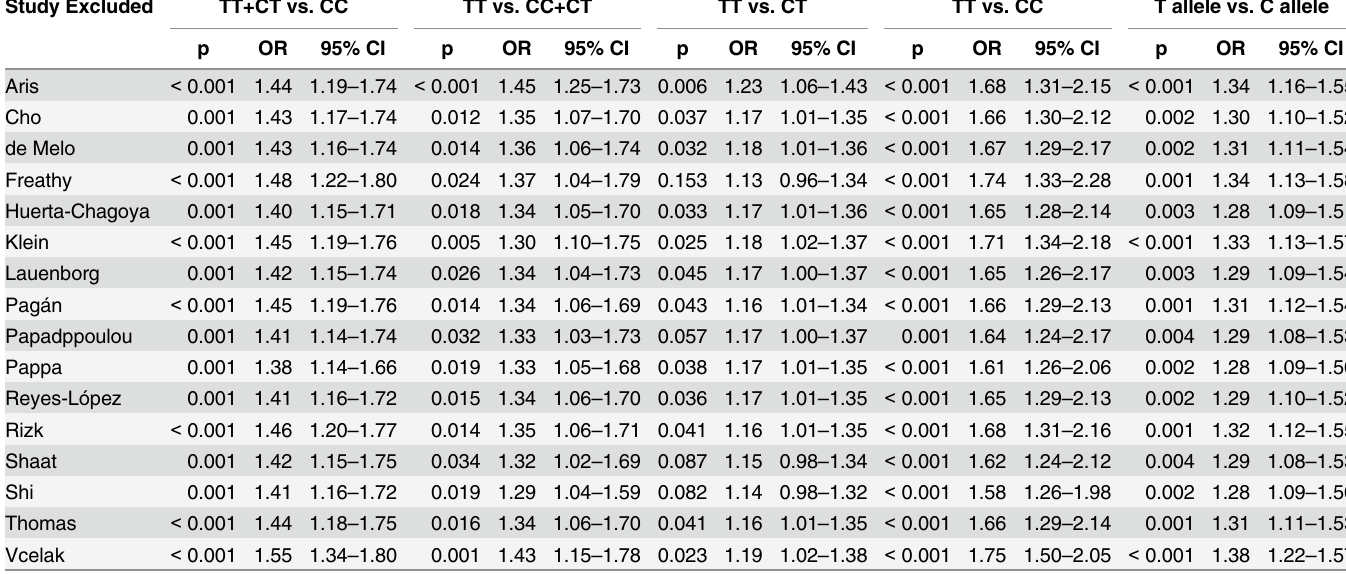
Table 5. Leave-one-out sensitivity analyses: Meta-analysis fixed-effects estimates when a study is omitted at a